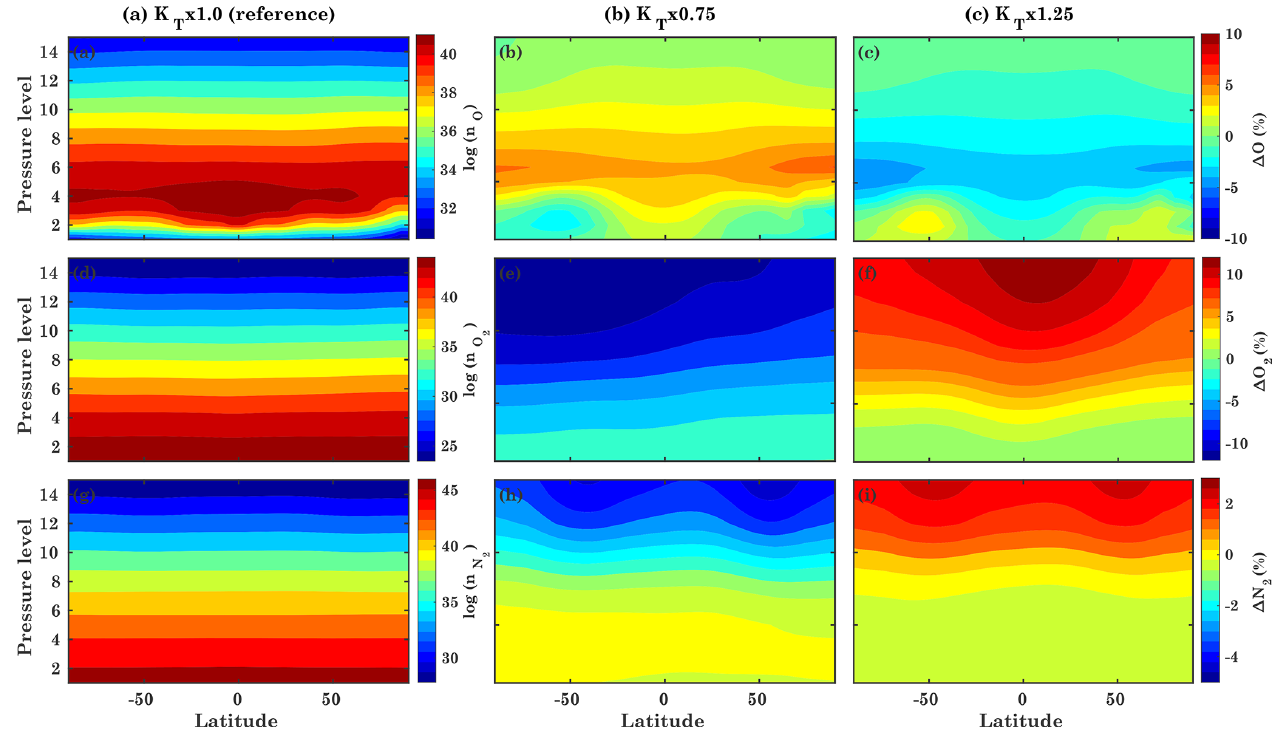
Figure 11. Same as Fig. 10 but for n O , n O